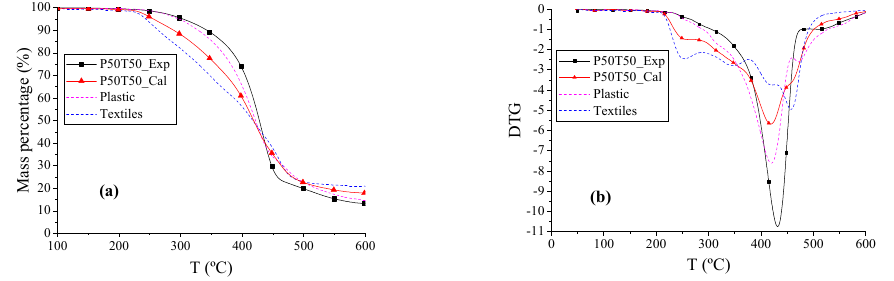
Figure 4. The TG and DTG thermograms of P, T, and P50T50. ( a ) TG thermograms reflects the change in mass percentage during pyrolysis process. ( b ) DTG thermograms refer to the derivative curves of TG